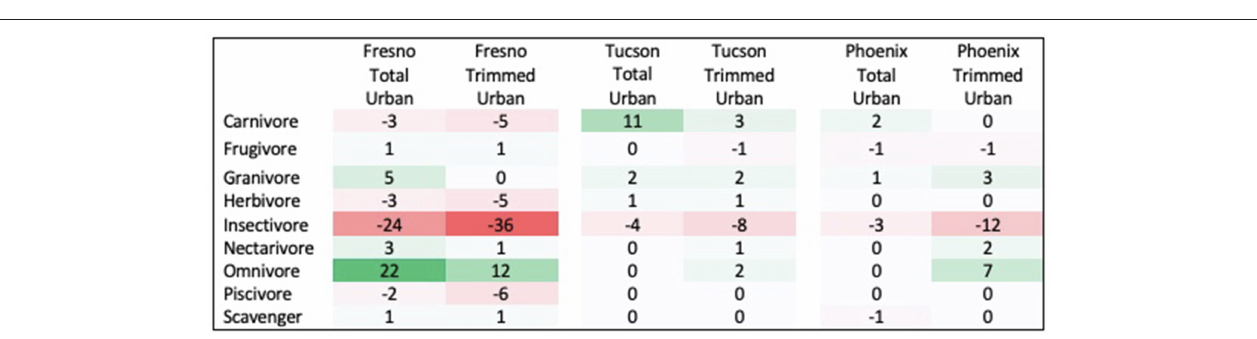
the winter ( χ 2 = 17.199, p = 0.041). In spring, Fresno’s